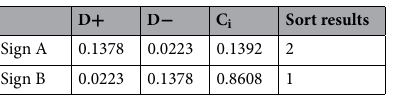
Table 4. Effectiveness evaluation results for two types of early warning